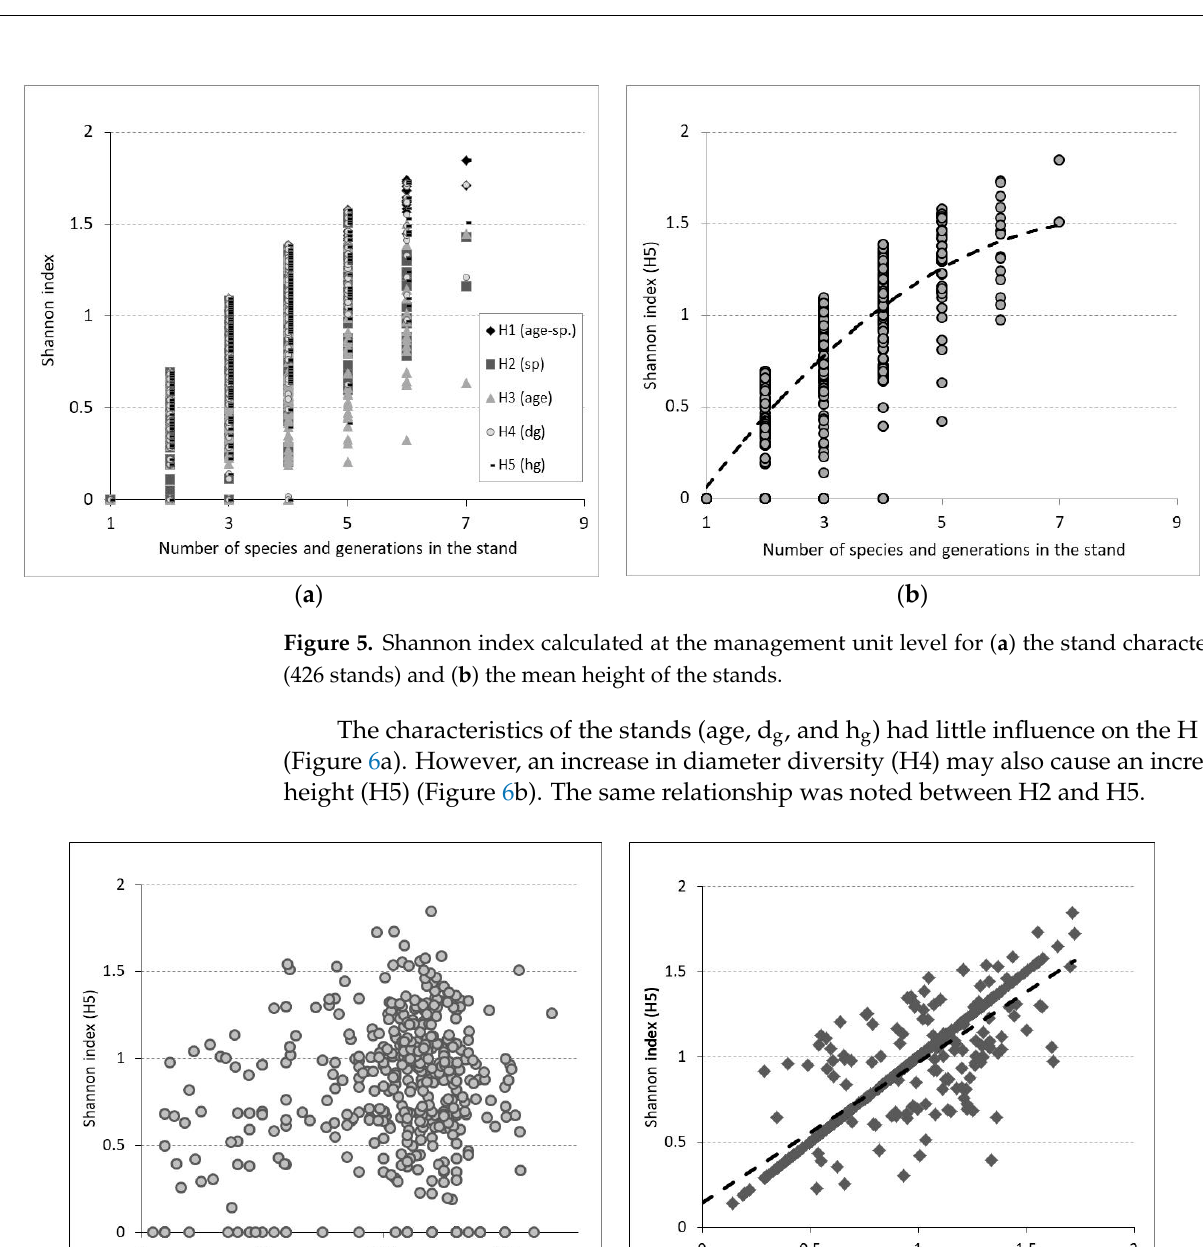
(c) Figure 7. Structure of ( a ) mixed sessile oak–beech stands, ( b ) beech stands, and ( c ) mixed beech–fir stands. See Table 5 for the characteristics used. Table 5. Characteristics used in Figure 7. Stand